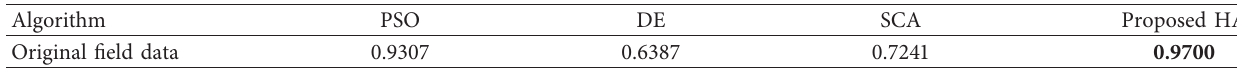
Table 7: The correlation coefficient between the obtained scattered field data and the original field data. Algorithm